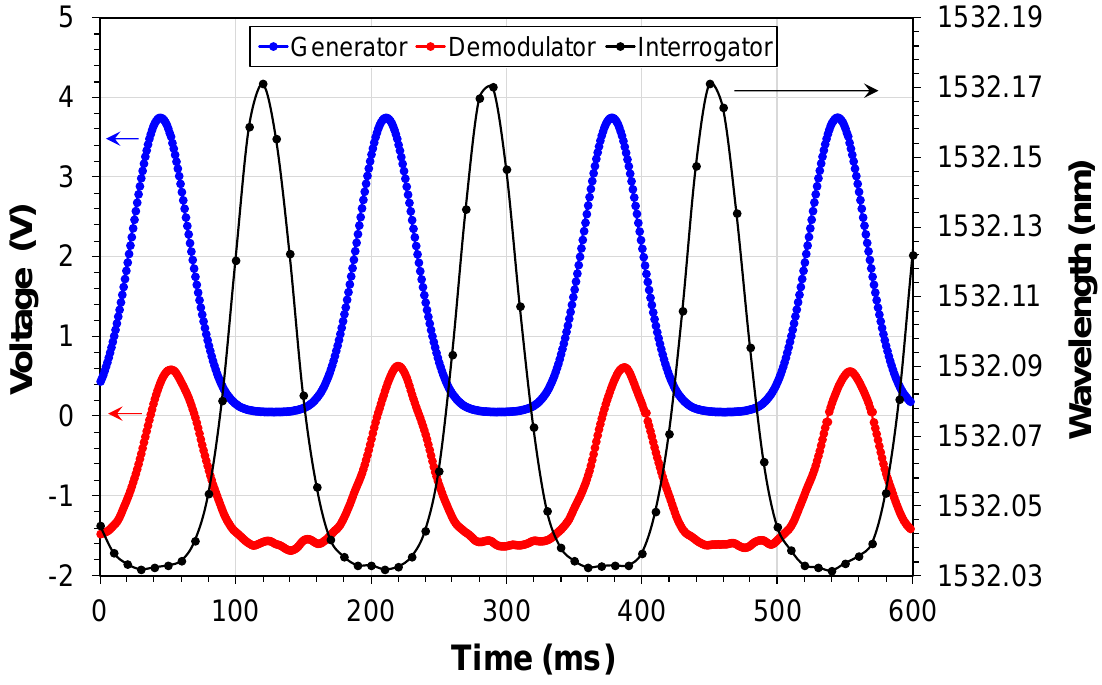
Figure 6. Qualitatively comparison of the signal of the waveform arbitrary generator, the signal in the demodulator output, and the signal measured using a commercial FBG interrogator. Figures 7a,b show the linearity performance respectively for the demodulator and for the commercial interrogator for four different FBG center wavelengths from 1532.03 to 1532.78 nm. The optical input power in the photodetector was −16 dBm.